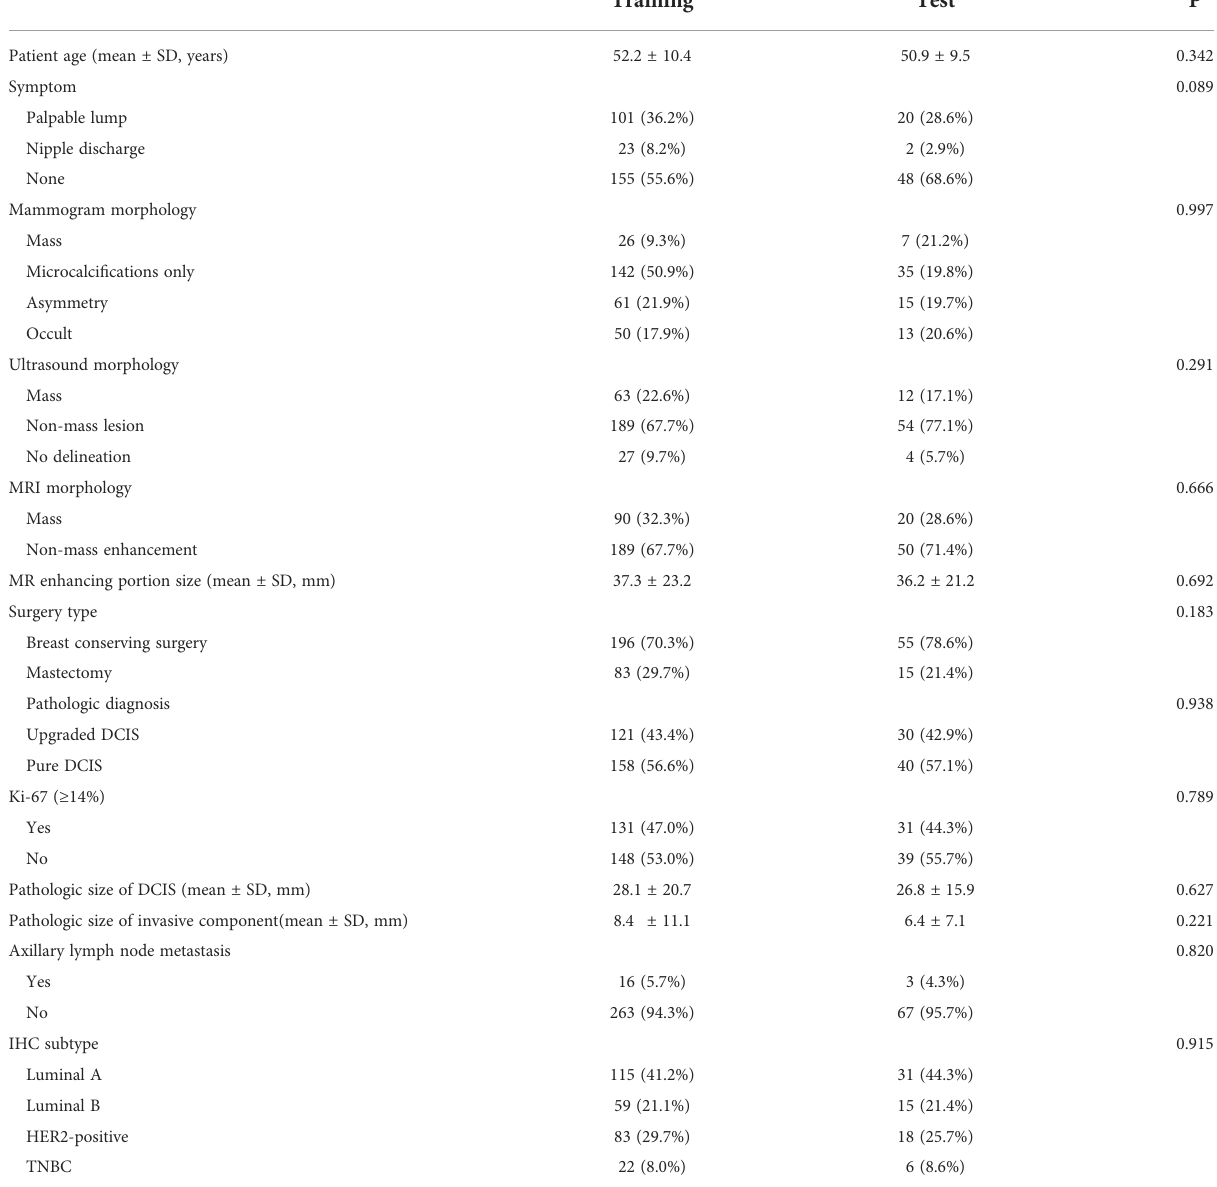
TABLE 1 Comparison of baseline characteristics between training (n = 279) and test (n = 70)